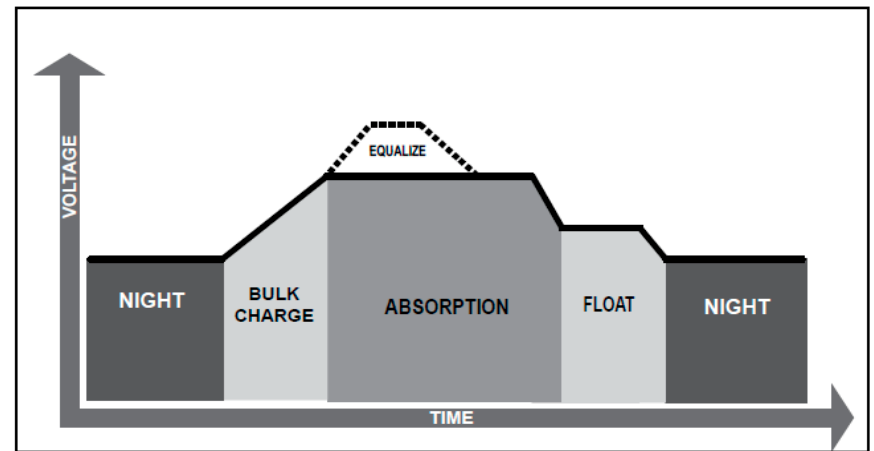
Figure 2. MPPT Charging Algorithm (Adapted from ref. [29]).